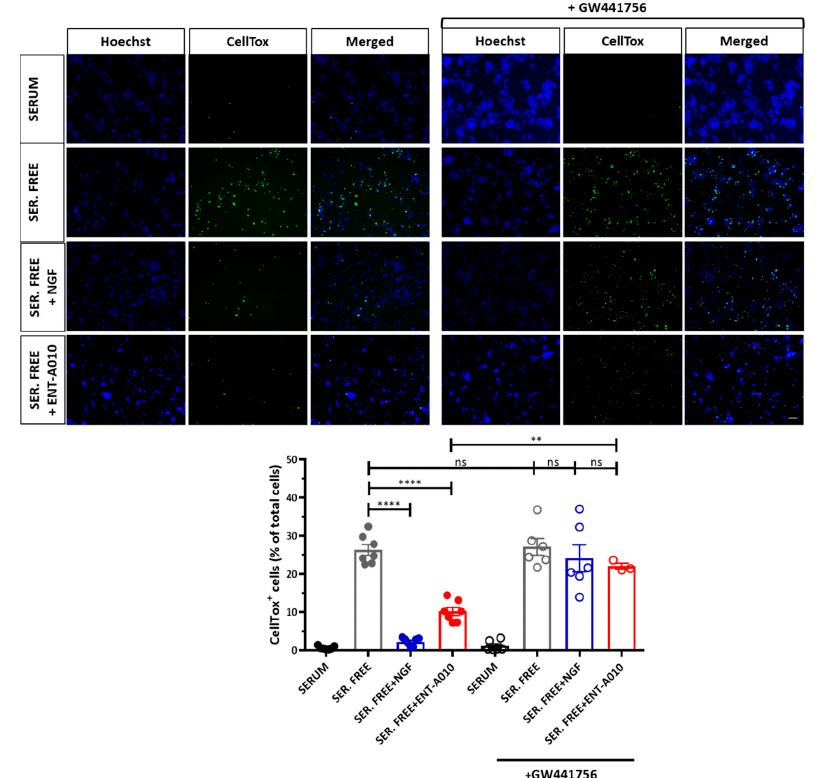
Figure 3. ENT-A010 promoted survival of PC12 cells via TRKA. PC12 cells were treated for 24 h with NGF (100 ng/mL), ENT-A010 (500 nM) or vehicle control, with or without the selective TRKA inhibitor GW174456 under serum starvation. Upper panel: Cells were stained with CellTox (green) and Hoechst (blue). Scale bar: 200 μ m (applies to all photos). Lower panel: Quantification of cell viability, calculated as percentage of dead (CellTox + ) cells per total number of Hoechst + cells in each image. Data are shown as mean ± SEM, n = 3–7, **: p < 0.01, ****: p < 0.0001, ns: non-significant.